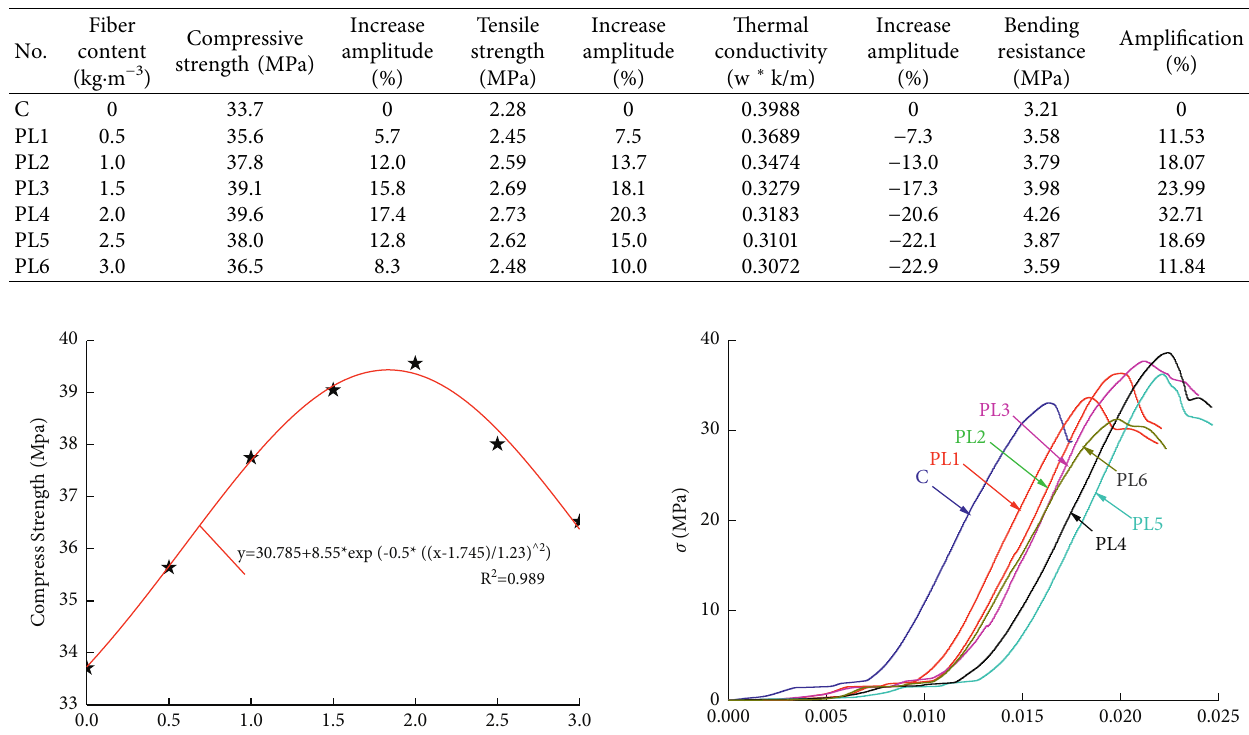
Table 6: Physical and mechanical parameters of shotcrete.